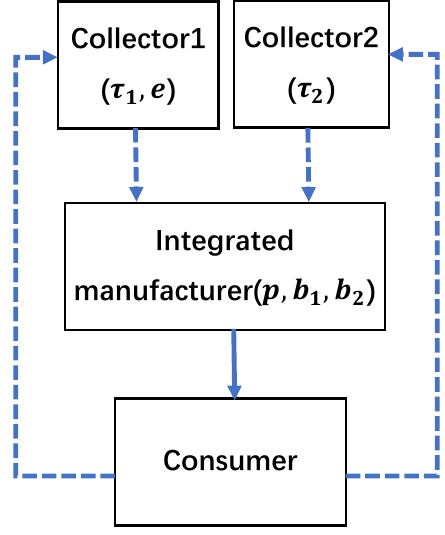
Figure 3. The CLSC structure of model H